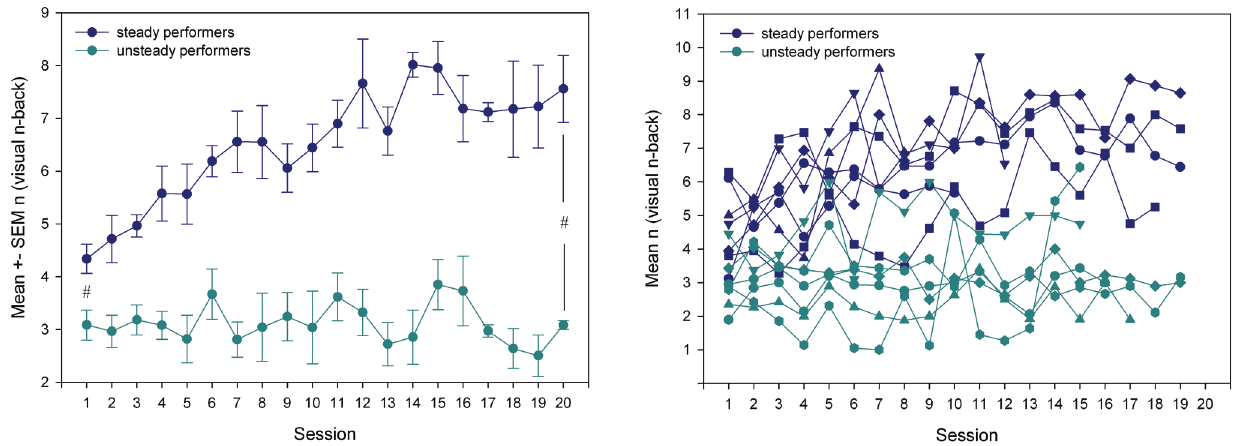
Figure 6. Visuospatial training performance for the steady and unsteady performers. Steady performers: individuals with a significant positive correlation between mean training performance (mean n) per session and the training session. Unsteady performers: no positive correlation. Left: mean ± SEM of n [visuospatial training task (VNB)] over each training session per group. Right: individual mean n (VNB) per training session. Blue: steady performer group. Green: unsteady performer group. # indicates significant performance differences between steady and unsteady performers at the first and the last session (unpaired t-test, p <